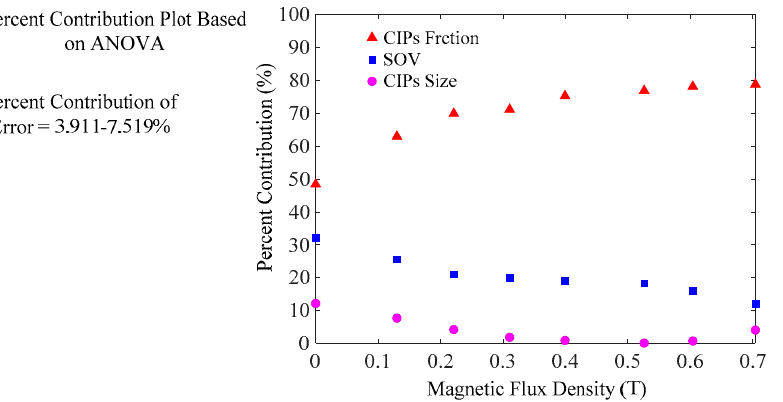
Figure 4. Percent contribution as a function of the SOV, CIPs fraction, and CIP size under different magnetic fields.